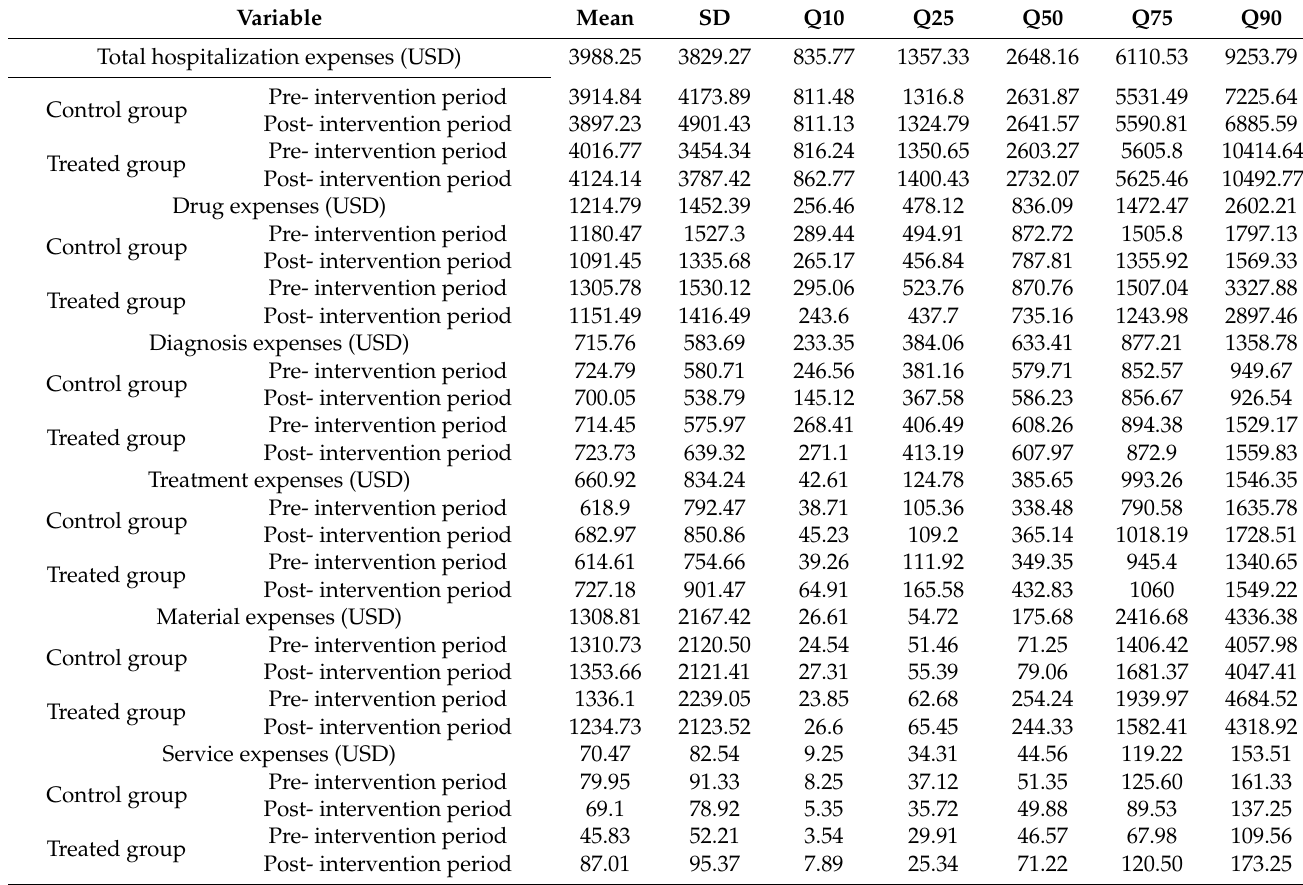
Table 2. Descriptive statistics of unadjusted hospitalization expenses for per inpatient over two time periods and by treatment group